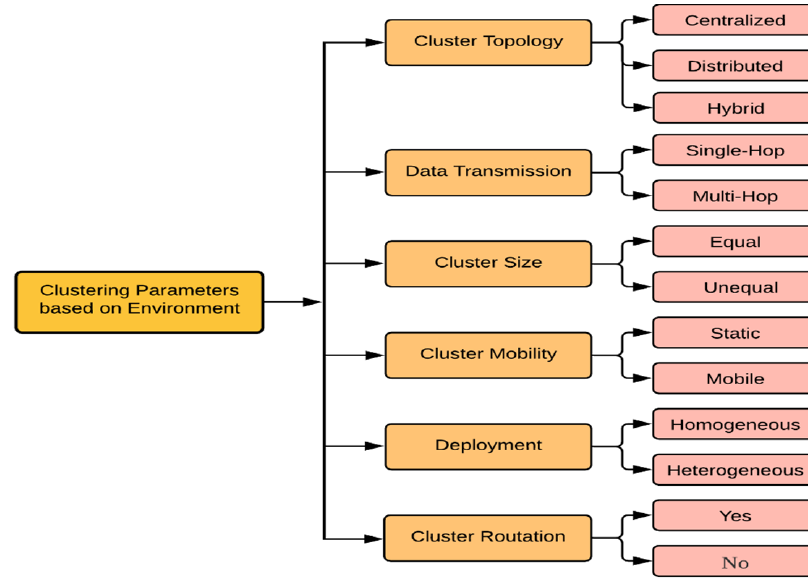
Figure 11. An overview of clustering parameters from the literature.